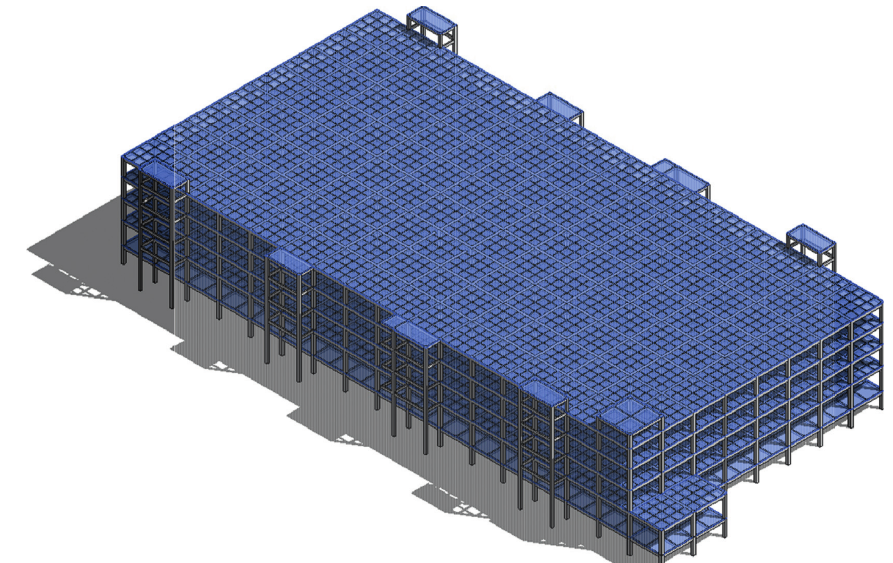
Figure 4: BIM model of the reinforced concrete frame